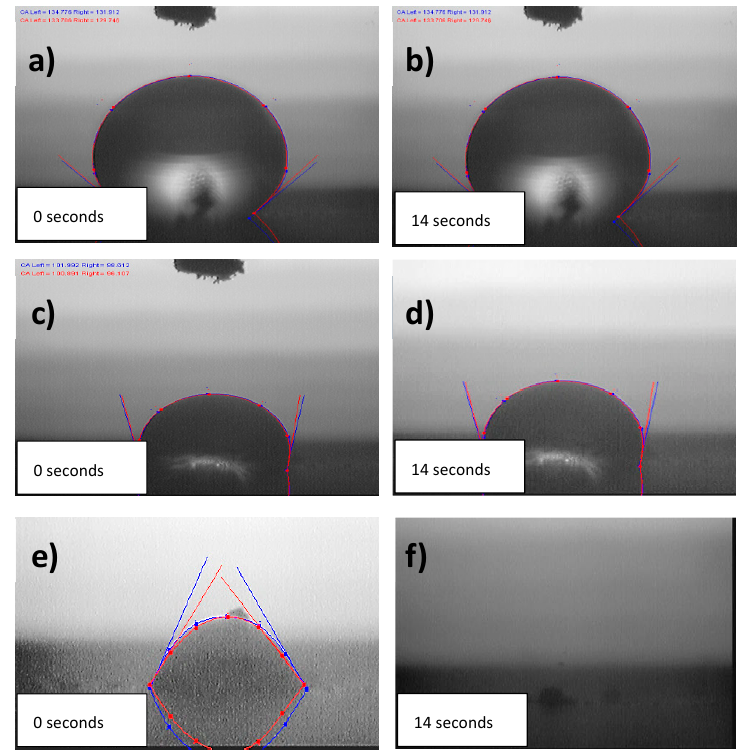
Figure 6. Water Contact Angle of ( a , b ) PVDF ( c , d ) AC electrode and ( d , f ) AC/GO-5 electrode.